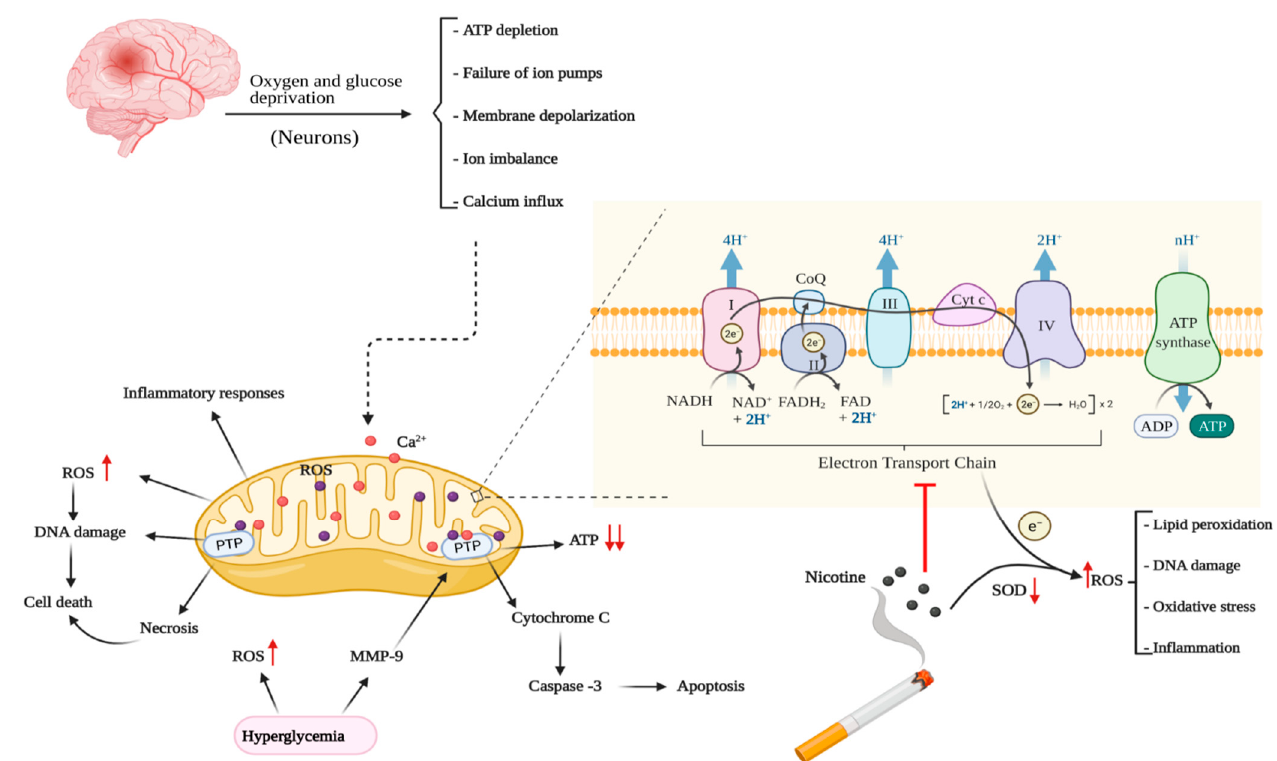
Figure 4. Effects of nicotine/smoking and diabetes on mitochondrial energy metabolism of neurons in ischemic stroke (created in BioRender).